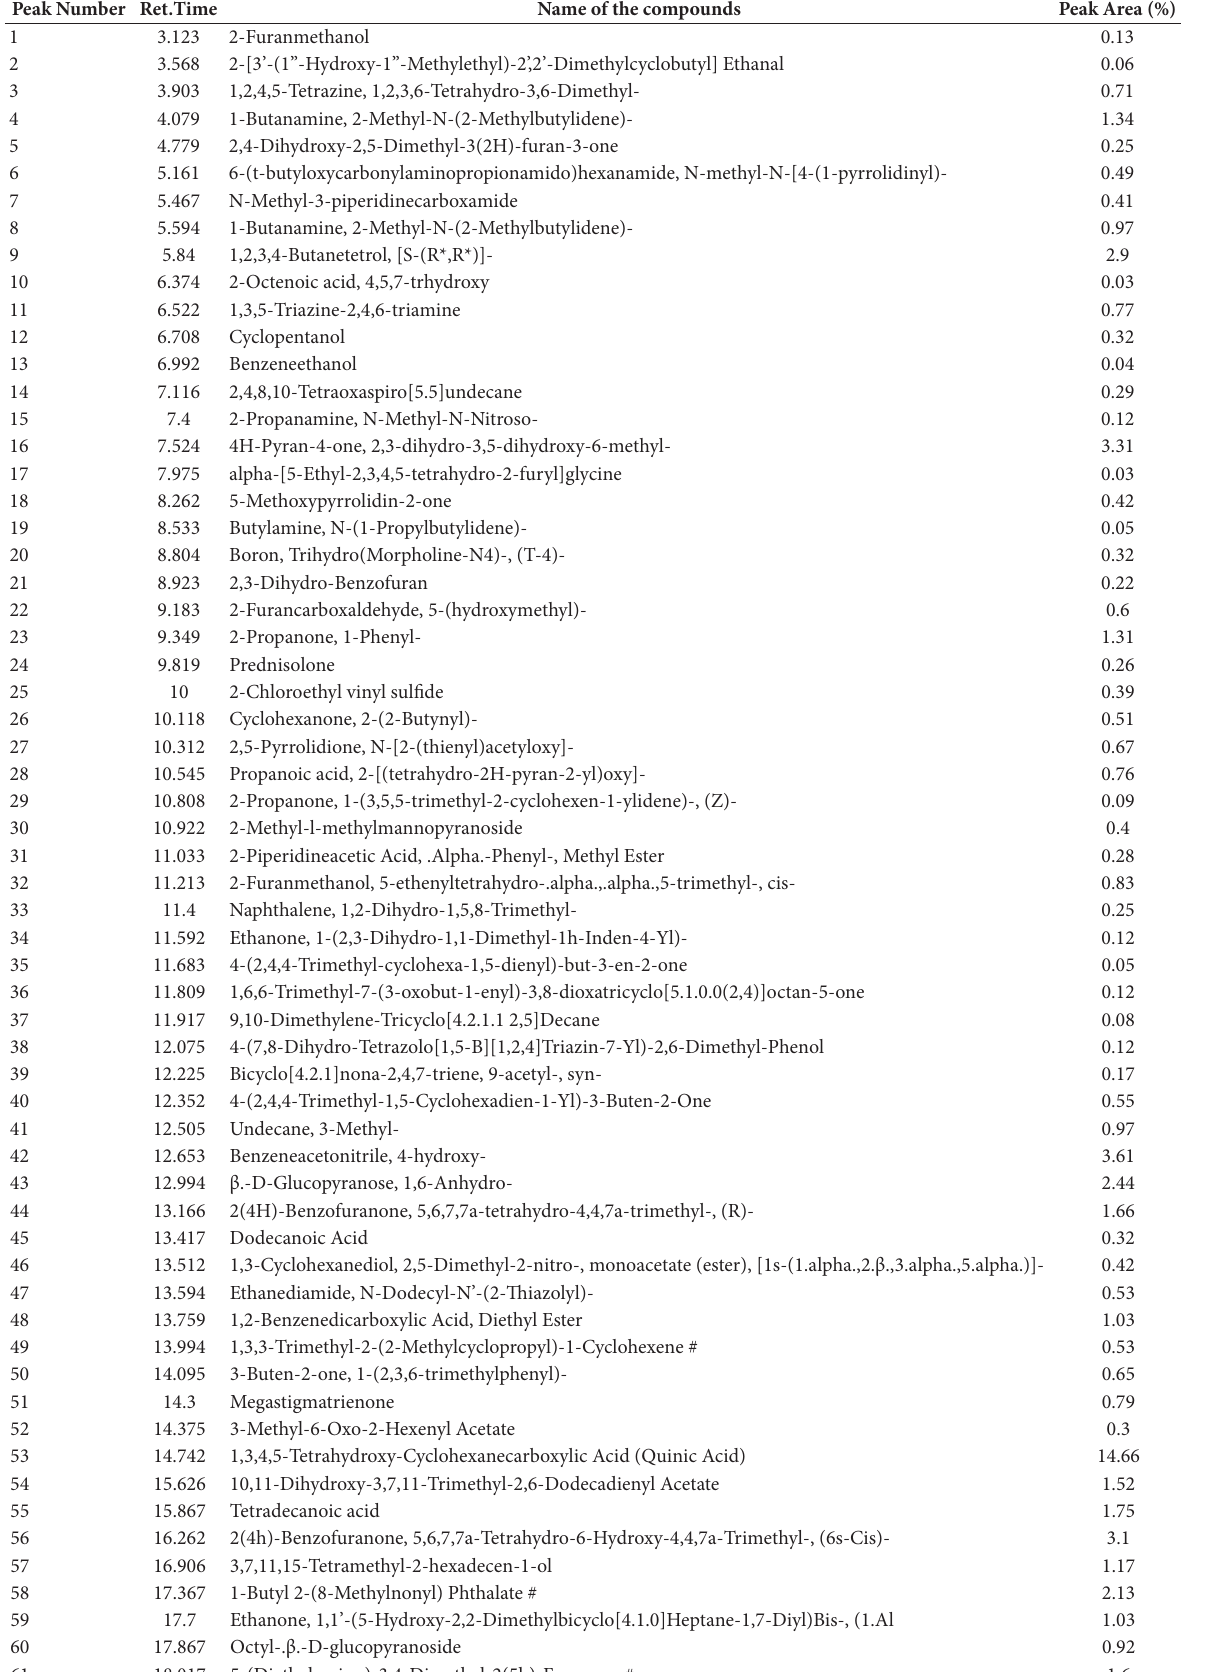
Table 2. Phytocomponents identified in the methanol extract of M. oleifera leaves by GCMS. Peak Number